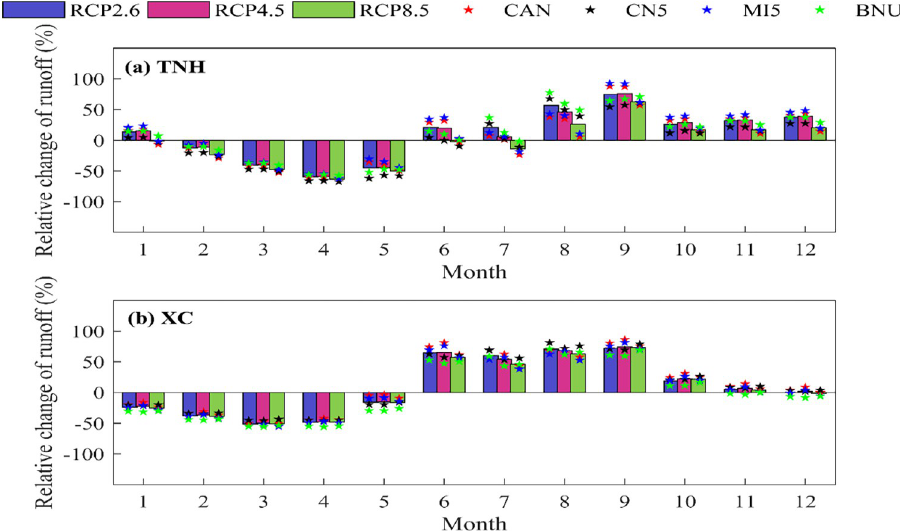
Fig 8. Future percentage change of runoff (bar graph represents the ensemble average of four GCMs under different RCPs).